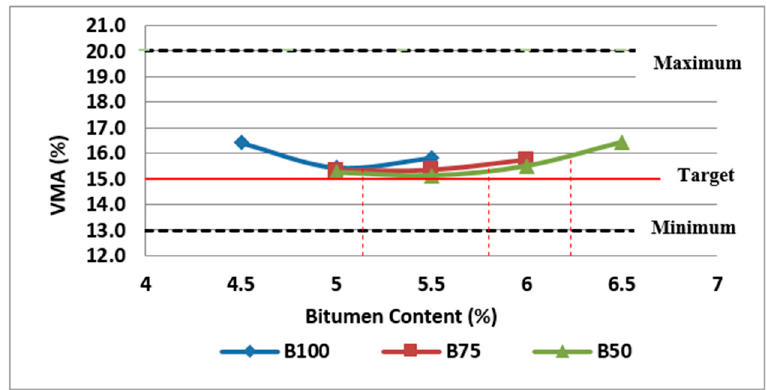
Figure 5. Effect of bitumen content and RCA content on VMA of Mix I containing virgin aggregate and Mix II and Mix III containing RCA as coarse aggregate.